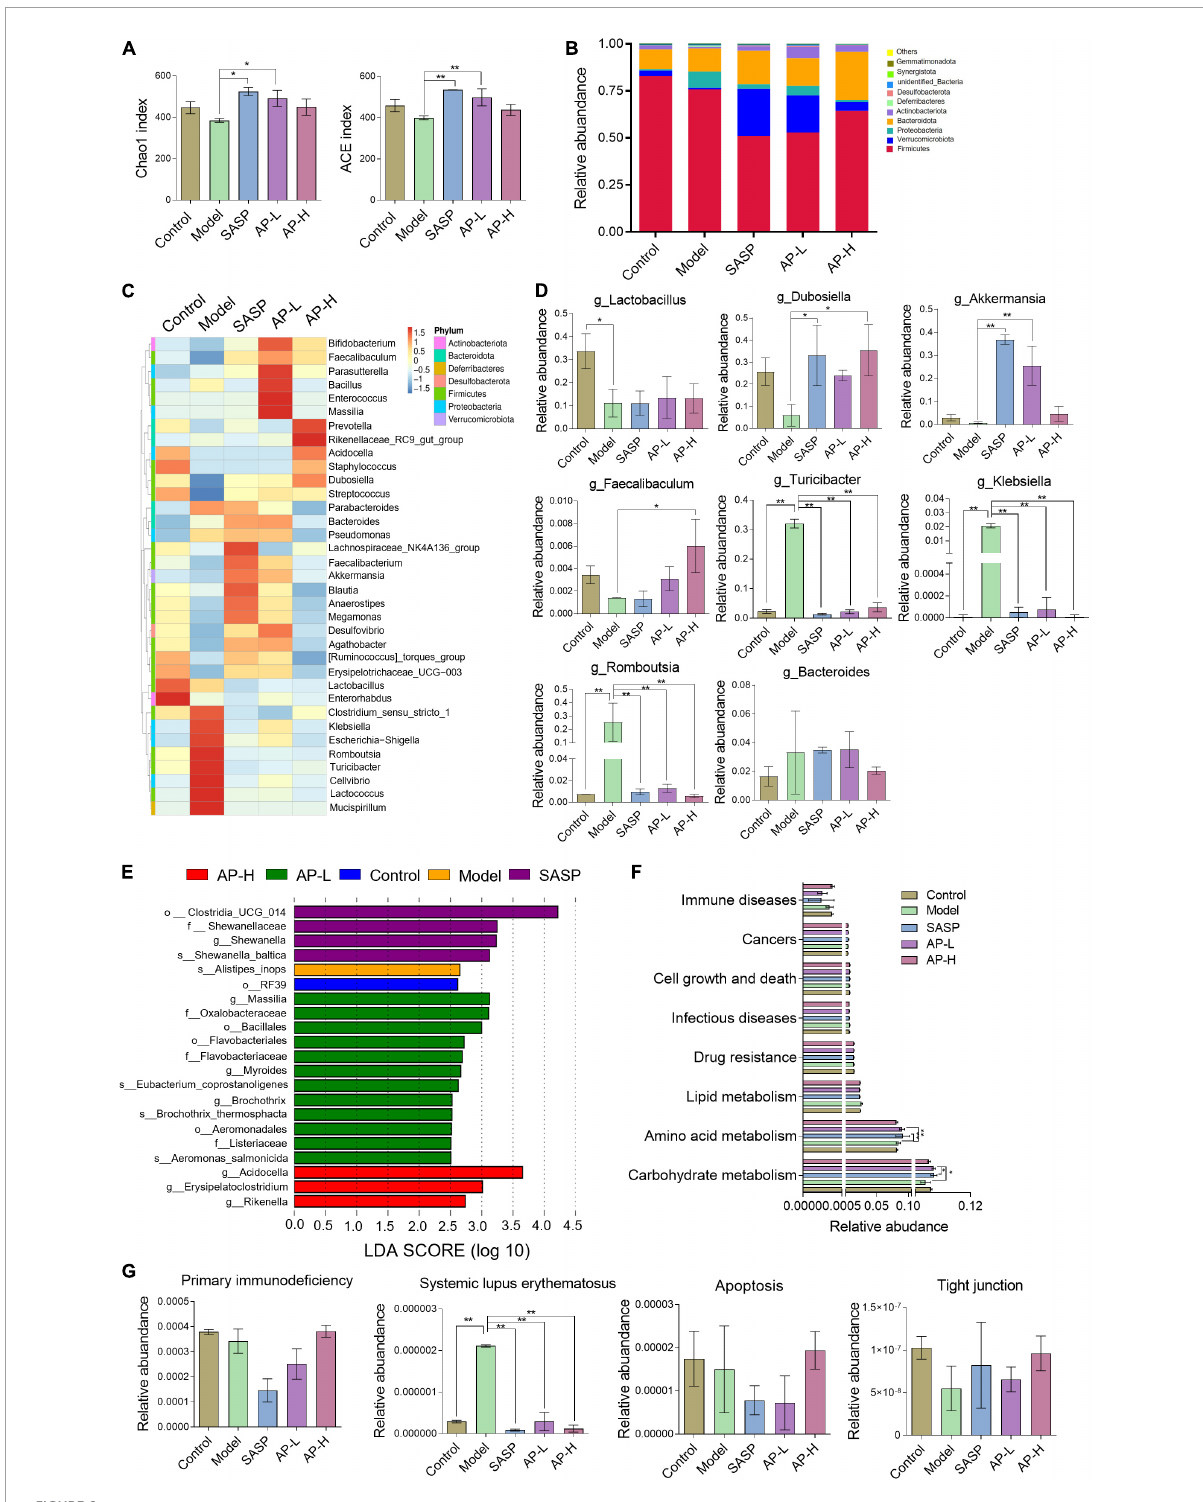
FIGURE6 Effect of apigenin on gut microbiota in UC mice. (A) Chao1 and ACE index of samples. (B) Relative abundance of the top 10 microbial groups at the phylum level. (C) Community heatmap at the genus level. (D) Relative abundances of dominant bacteria at the genus level between different groups. (E) LDA discriminant histogram. (F) Microbial catabolism function of KEGG pathways among control, model, SASP, AP-L, and AP-H groups. (G) The effect of apigenin administration on primary immunodeficiency, systemic lupus erythematosus, apoptosis, and tight junction. * P < 0.05, ** P <